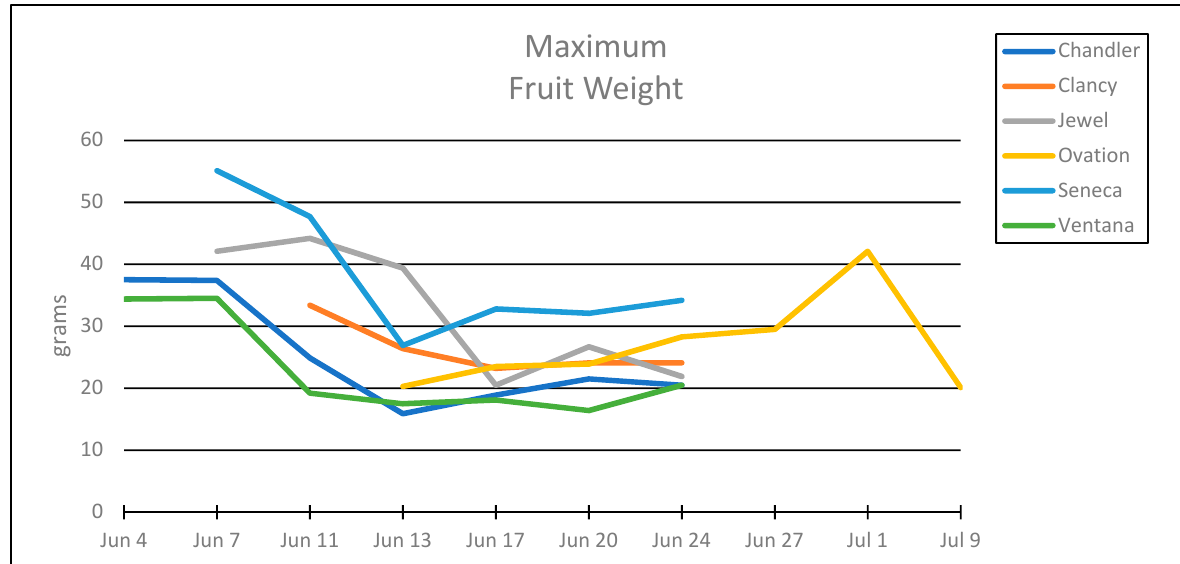
Figure 6. Minimum and maximum daily temperatures in Trial 2 from the date of straw removal (16 March 2014) through the end of harvest (9 July 2014) harvest in a trial of six short-day strawberry varieties grown in plasticulture in a cold climate region (central NY).